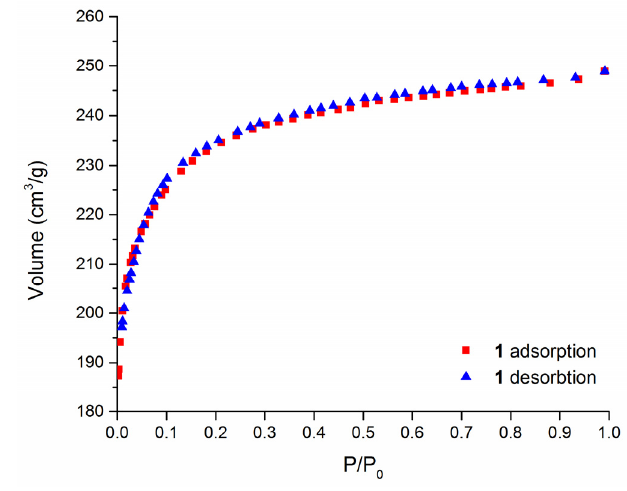
Figure 8. The N 2 isotherm of 1 , measured at 77 K. Table 2. Micropore, mesopore and total pore volume for 1 . The powder X-ray diffractogram registered after the sorption measurement displayed little differences when compared to the one registered for the activated material. Therefore, we decided to submit the same sample to a total of five adsorption/desorption cycles, in order to assess the frameworks’ robustness. As can be seen in Figure 9, 1 displays good sorption properties even after 5 cycles, despite the BET value going down from 906 m 2 /g (cycle 1) to 784 m 2 /g (cycle 5).